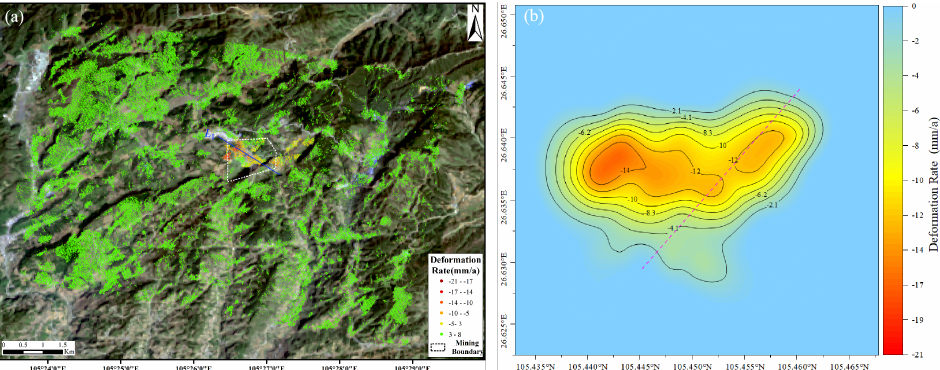
Figure 3. Result of DS-InSAR in the research area: ( a ) annual average deformation rate in the study area; ( b ) contour of deformation rate in study